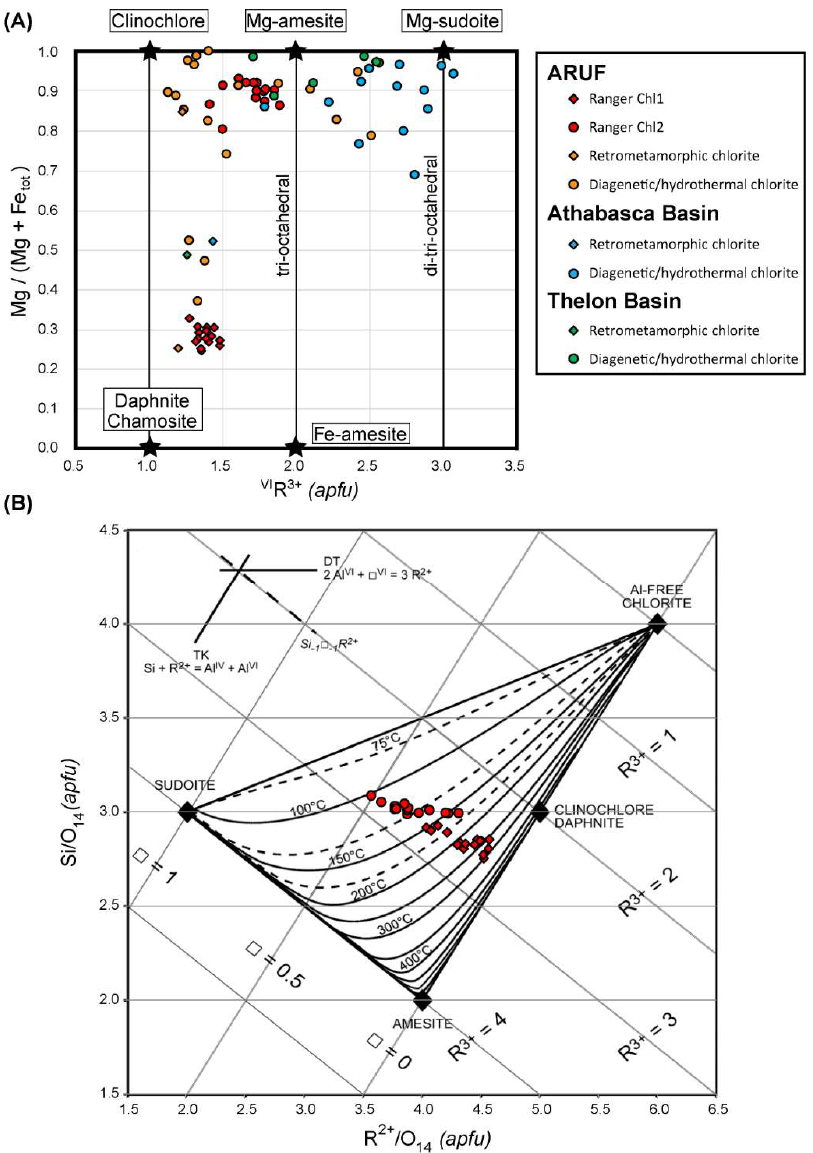
Figure 8. ( A ) Classification diagram of Plissart et al. [58] for tri‐ and di‐trioctahedral chlorite. Compositions of chlorite Chl1 and Chl2 from Ranger deposit (this study) are plotted together with chlorite from other deposits from the ARUF [30,46,58], the Athabasca Basin [11,59,60] and the Thelon Basin [19] for comparison. For data from the ARUF (except for Ranger, this study) and the Canadian basins, the plotted data corresponds to the mean compositions for each sample or generation. ( B ) Distribution of temperatures for chlorite Chl1 and Chl2 from Ranger deposit (this study) determined by chlorite thermometry plotted in a T‐R 2+ ‐Si diagram, with R 2 = Mm + Mn + Fe ( apfu ) [57].